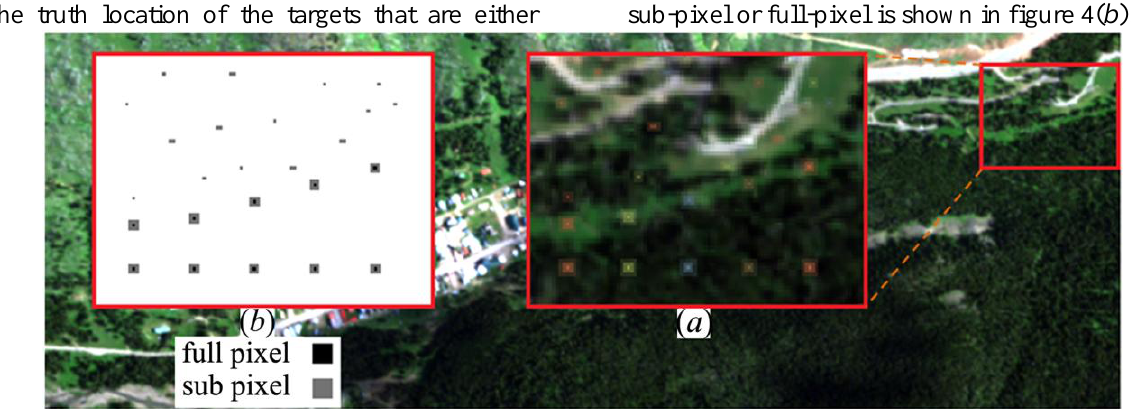
Figure 4. A natural color composite of the HyMap data cube, (a) selected sub-image with implanted targets (Img-I), (b) truth location of targets [26].